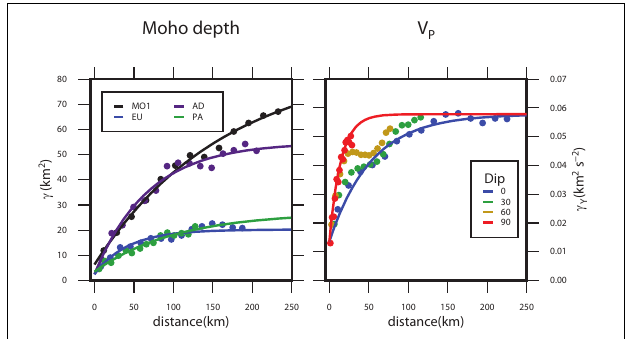
FIGURE 4 | Experimental and model variograms (semivariance vs. distance) for (left) Moho depth data considering a unique (MO1) or three surfaces (EU, AD, PA); (right) V P for different dip directions. Details in the two